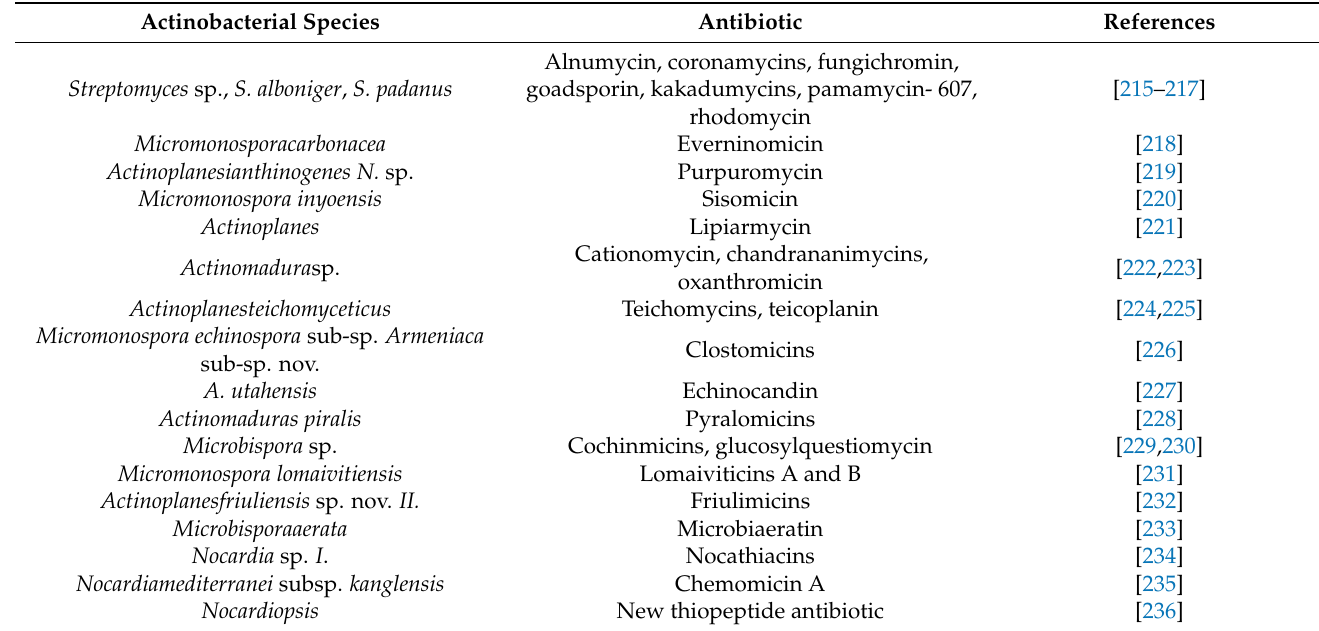
Table 3. Antibiotic producing actinobacteria.